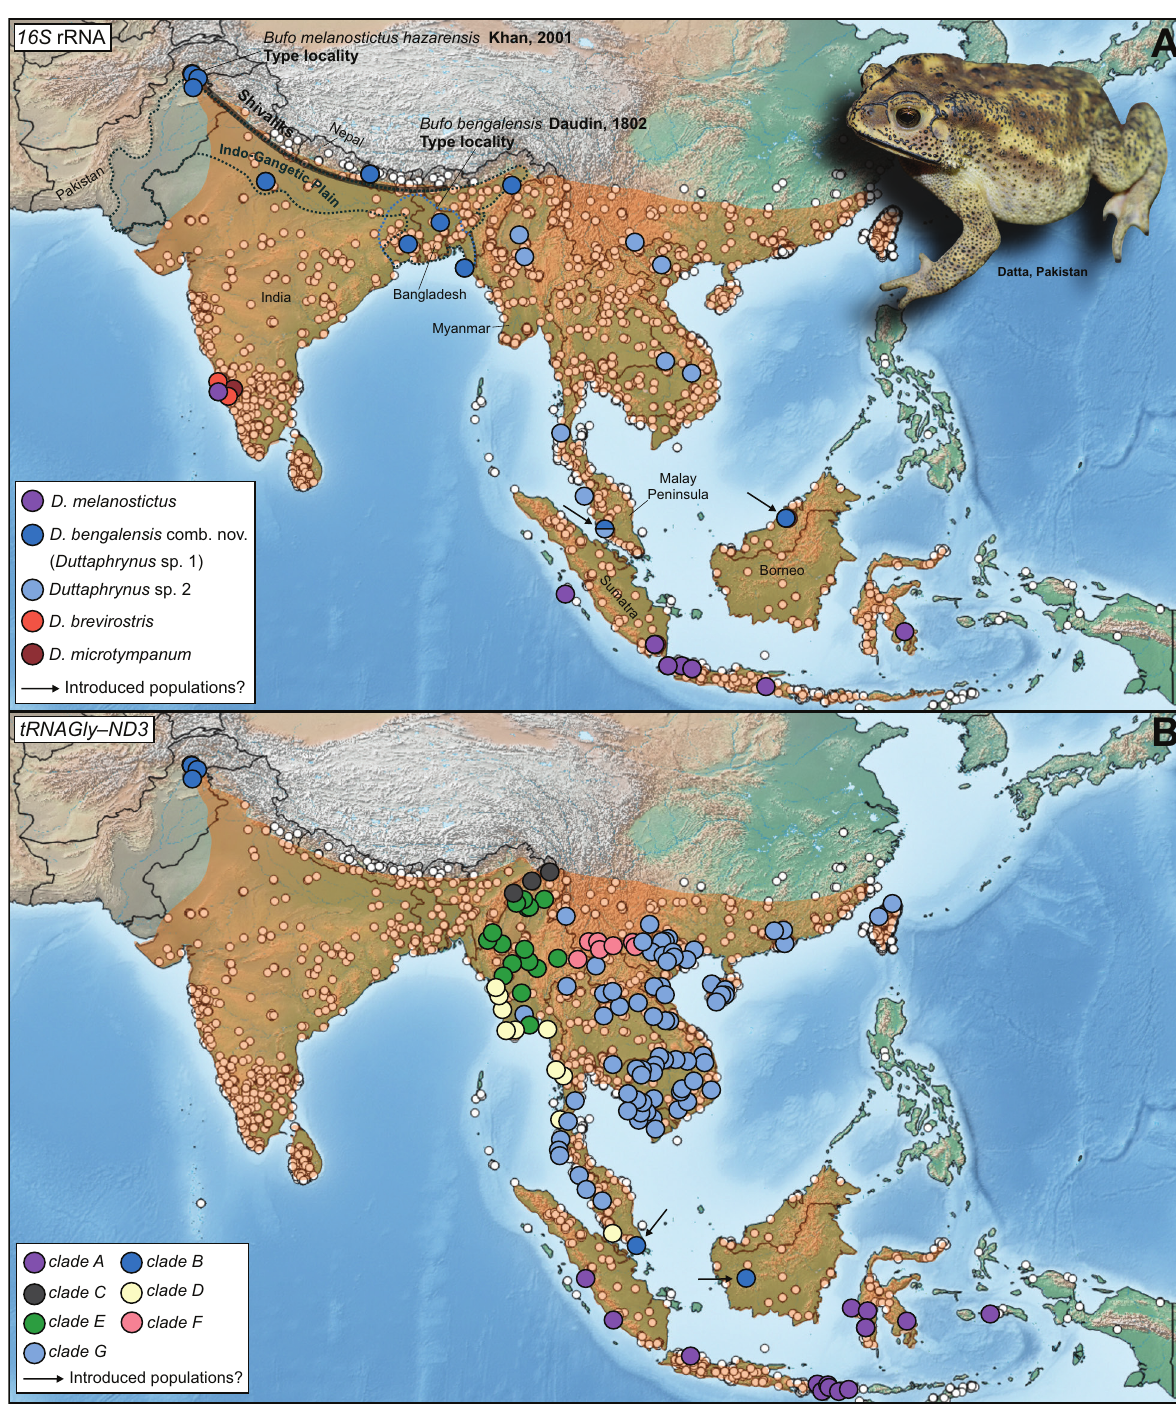
Figure 2. Phylogeographic reconstruction and distribution of major clades of the Duttaphrynus melanostictus complex across the species range based on 16S rRNA ( A ) and tRNAGly–ND3 ( B ) sequences available in GenBank and from own data (see Suppl. ma- terial 1: Table S1). The clade colors follow those of Fig. 1, clade terminology is derived from Bisht et al. (2021; 16S rRNA), and Vences et al. (2017; tRNAGly–ND3 ). The pictured individual represents the population of Duttaphrynus bengalensis comb. nov. (Daudin, 1802) from Datta, Mansehra, Pakistan. Coloration reflect the main mtDNA clades according to Fig. 1. Distribution records (white circles) have been downloaded from GBIF (gbif.org). The red line (panel A) depicts the area considered as “Bengal”, the type locality of Bufo bengalensis